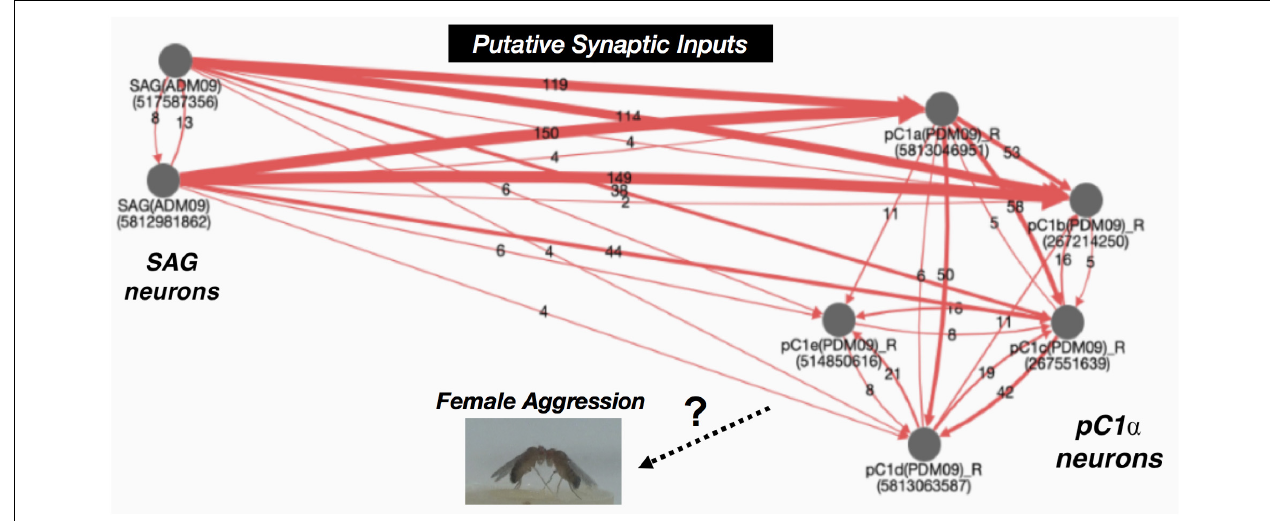
FIGURE 2 | Connectivity graph of SAG neurons and pC1 α neurons. SAG neurons project major inputs into the pC1 α neurons. pC1 α neurons make reciprocal connections within the pC1 neuronal cluster. Red lines indicate synaptic connections and the numbers within the arrows represent number of shared synapses. Arrows indicate putative target. Numbers underneath traced neurons indicate the ID number from the neuPrint server (https://neuprint.janelia.org/) (Zheng et al., 2018; Scheffer et al., 2020; Wang et al.,